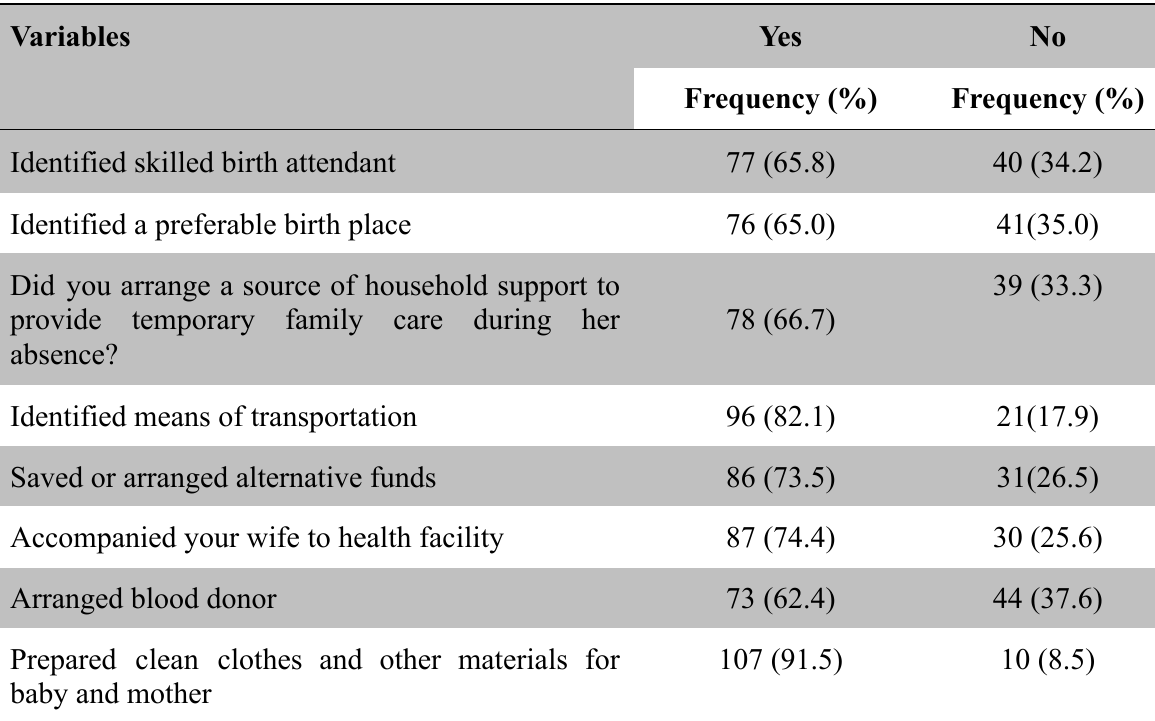
Table 2: Components of birth preparedness and complication readiness (n=117)